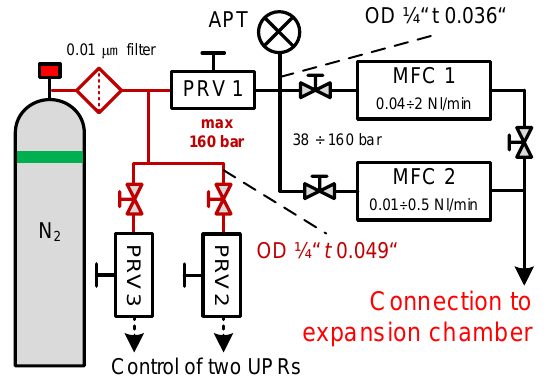
Fig. 1. Scheme of the gas branch of MPD: PRV – pressure regulating valve, APT – absolute pressure transducer, MFC – mass flow controller, UPR – upstream pressure